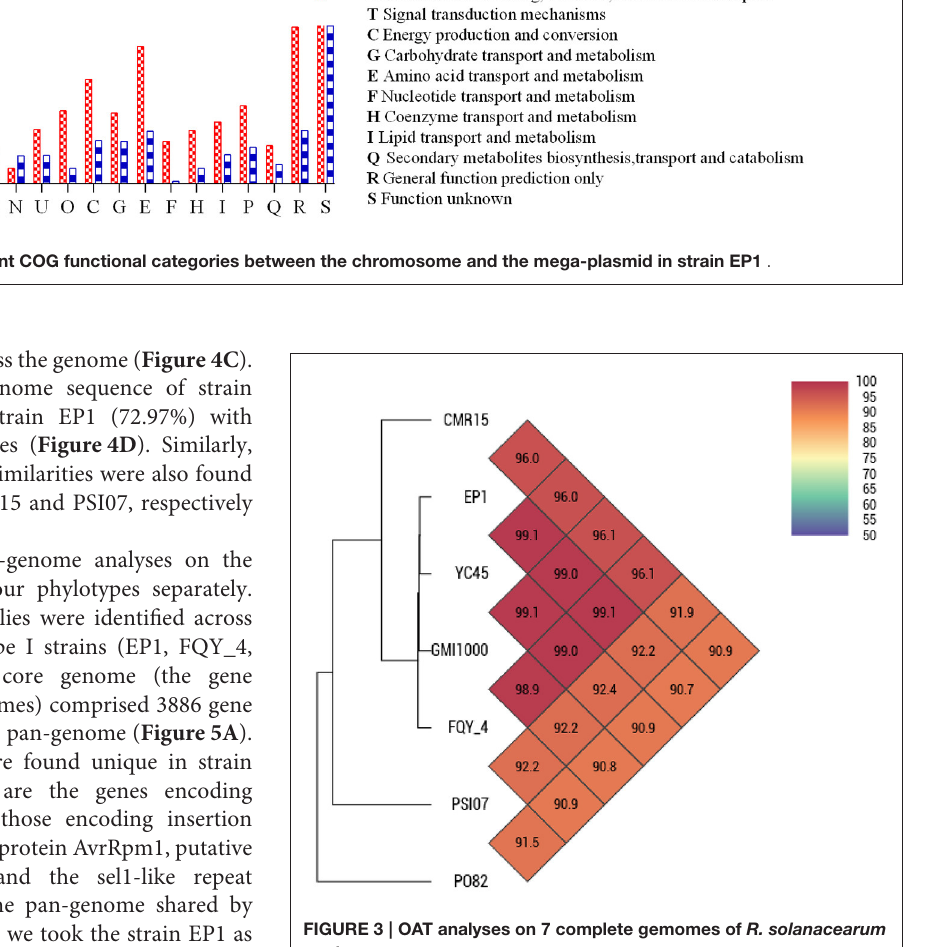
FIGURE 3 | OAT analyses on 7 complete gemomes of R. solanacearum